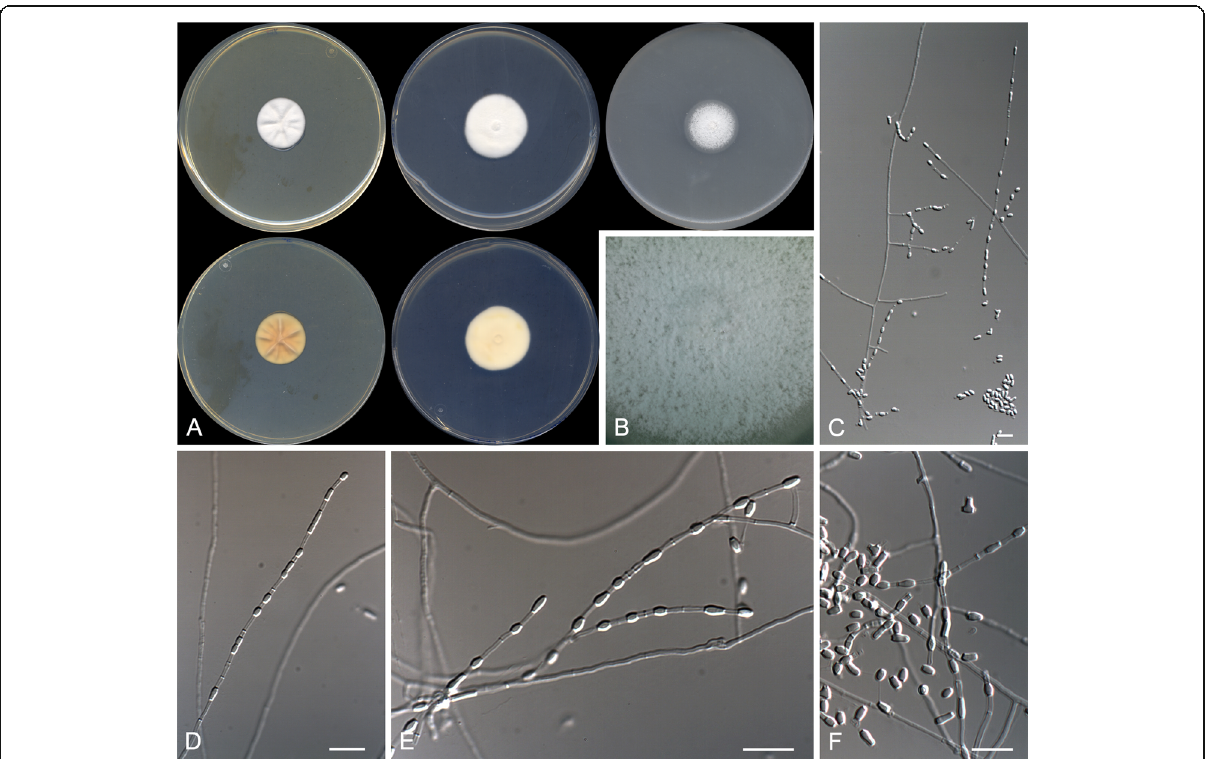
Fig. 11 Spiromastigoides geomycoides CBS 146934 T . a Colonies on PYE, PDA and OA after 14 d at 25 °C, from left to right (top row, surface; bottom row, reverse). b Detail of the colony on OA. c Fertile lateral branches mimicking Geomyces spp. conidiophores. d – e Fertile hyphae with intercalary, barrel-shaped arthroconidia. f Morphological diversity of arthroconidia. Scale bar = 10 μ m